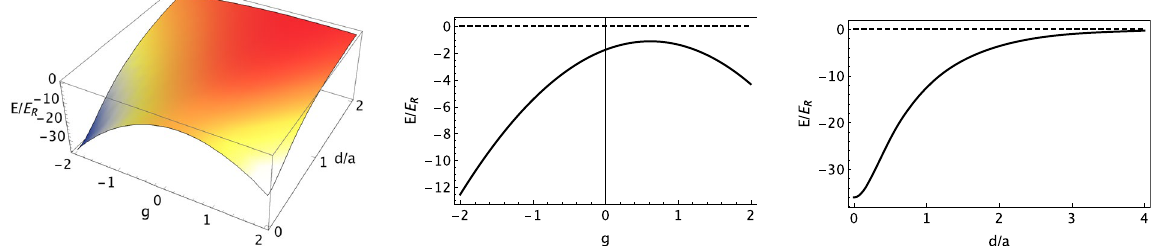
Figure 2. Energy for two impurity atoms as a function of their relative distance d (in lattice spacing a = λ /2 units) and as a function of = g g g / Aab Bab ( ) ( ) (left). Slice of the 3D plot at the fixed distance d = a showing how the interaction between two impurities in two neighbouring sites can be modulated by varying g (centre). (right) Energy for two impurity atoms as a function of their relative distance d (in lattice spacing a = λ /2 units) for g =